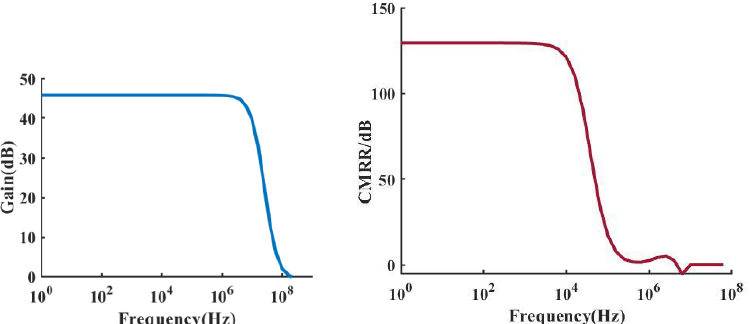
Figure 6. Gain and CMRR of the preamplifier.